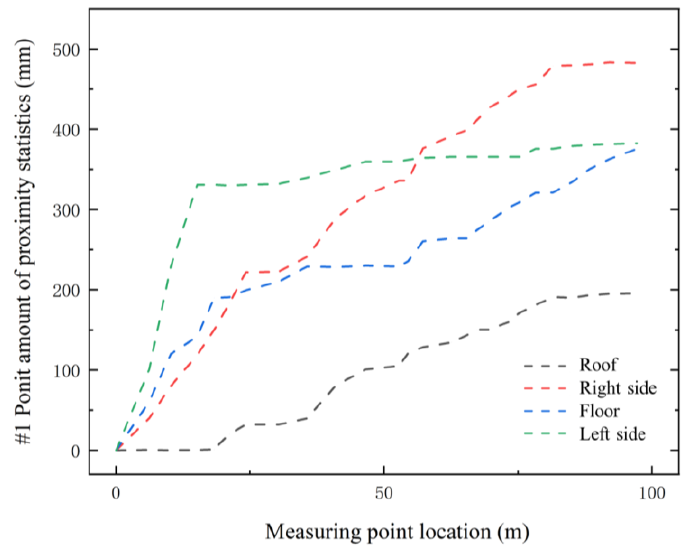
Figure 17. Variation law of roadway surface